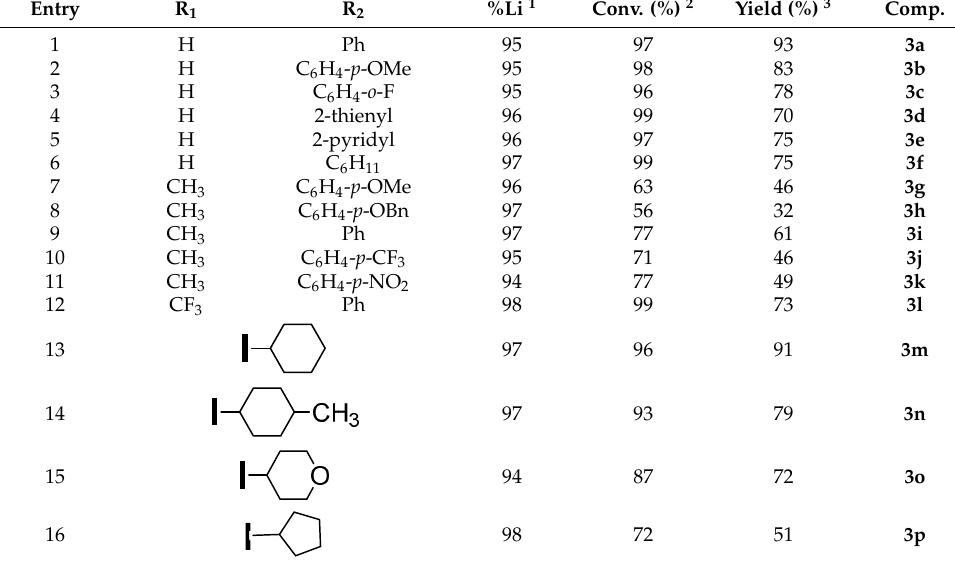
1 Degree of conversion (% Li) was estimated by 1 H NMR following a 1 h. quench with D 2 O at 22 °C under sonification. 2 Conversion measured by 1 H NMR of the crude reaction mixture prior to puri- fication. 3 Isolated yield after purification by silica-gel